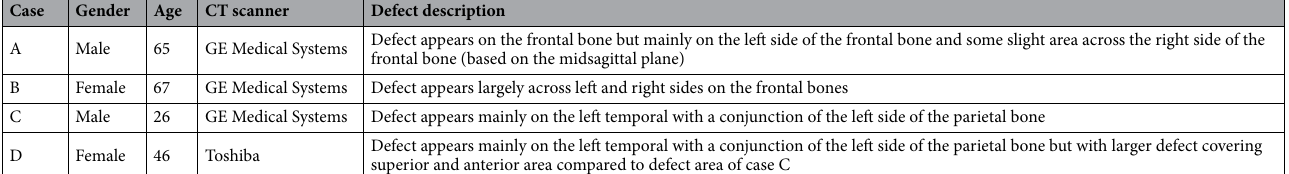
Table 1. Detail of craniofacial defects of four patients used in this